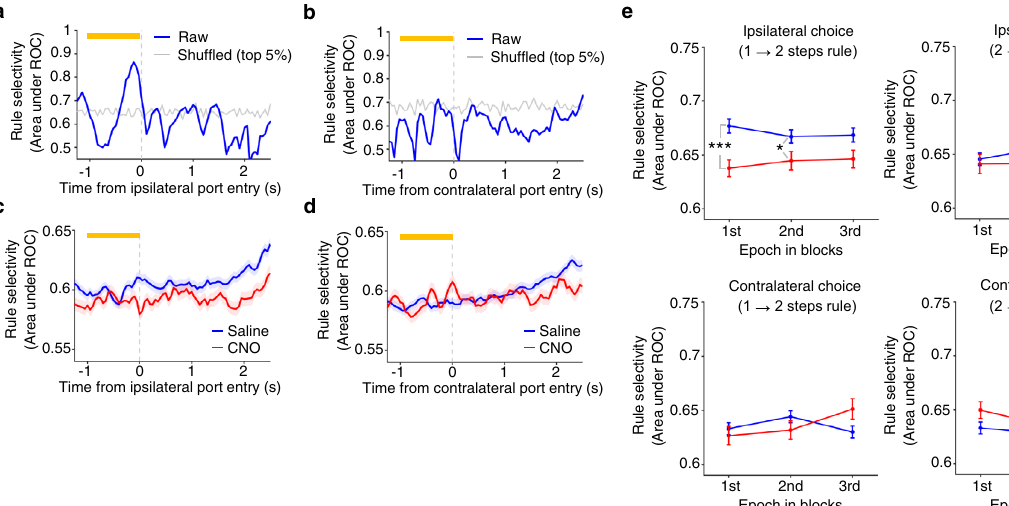
Fig. 6 | Chemogenetic silencing of ACC decreased rule selectivity in M2 neu- rons. a Time course of rule selectivity of a representative M2 single-unit (the same single-unit shown in Fig. 5b, c) for ipsilateral condition. Rule selectivity was quanti fi edby applyingROCanalysisto thedistributions ofmean fi ringrates during pre-choice period in trials of Rule Switch-blocks of 1 step and 2 steps conditions (see Methods for details). Gray line represents a 95% percentile level estimated by shuf fl ed data in which we randomly shuf fl ed rule labels for trials (1 stepor 2stepsconditions)beforecalculating thearea underROCcurve. Error bar, SEM. b Same as in a , but for contralateral condition. c Population-averaged time course of rule selectivity in ipsilateral condition. Blue, saline solution. Red, CNO solution. Shaded bands, SEM. d Same as in c , but for contralateral condi- tion. Shaded bands, SEM. e Comparison of rule selectivity between CNO and saline conditions and across three epochs in Rule Switch-blocks (1st epoch, 1 – 18th trials; 2nd epoch, 17 – 36th trials; 3rd epoch, 37 – 55th trials). See Methods Error bar, SEM. Source data are provided as a Source Data fi